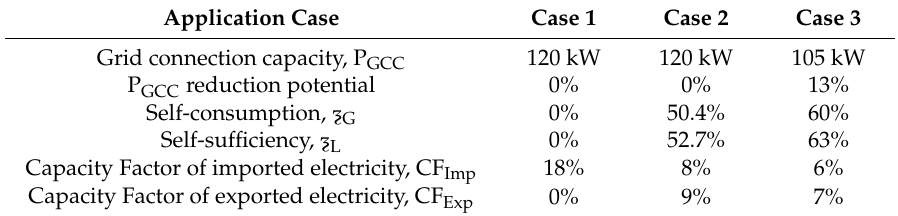
Table 6. Grid connection capacity, load matching and capacity factors in the analyzed cases.